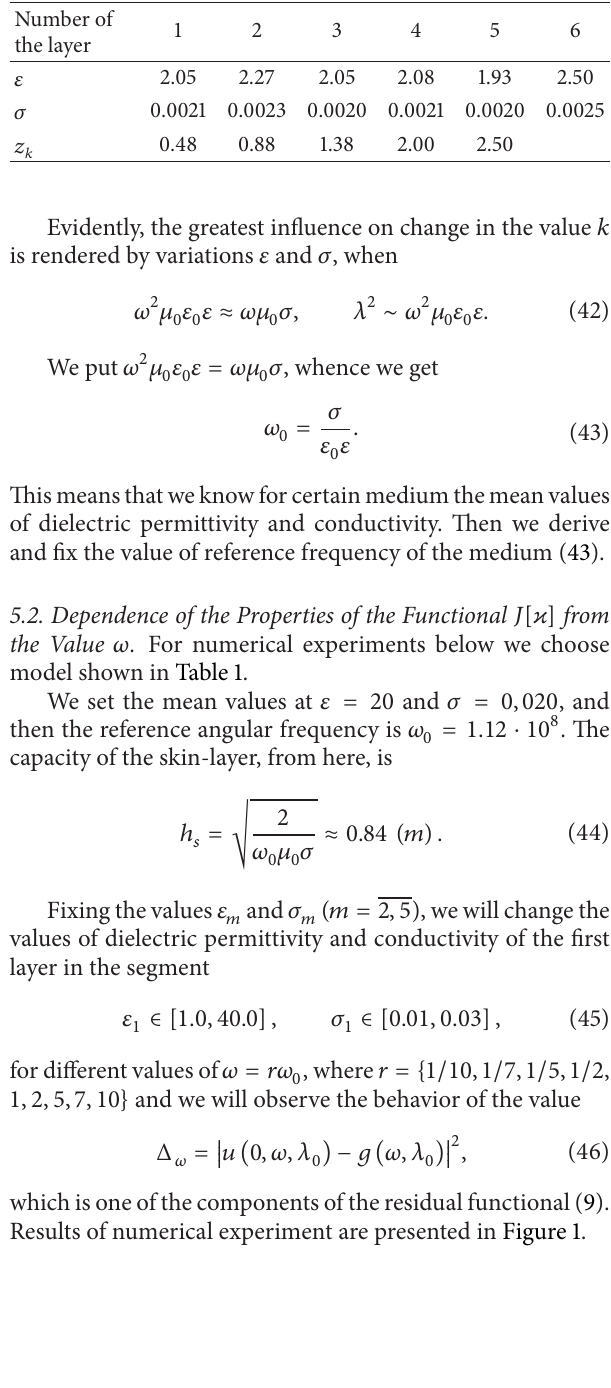
Table 3: Model of the medium